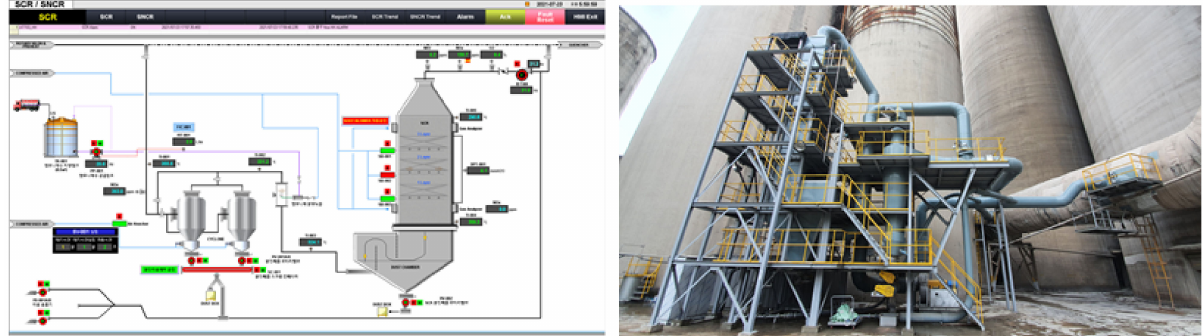
Figure 14. Pilot-scale SCR process operation screen and installation in Korean cement manufacturer G.